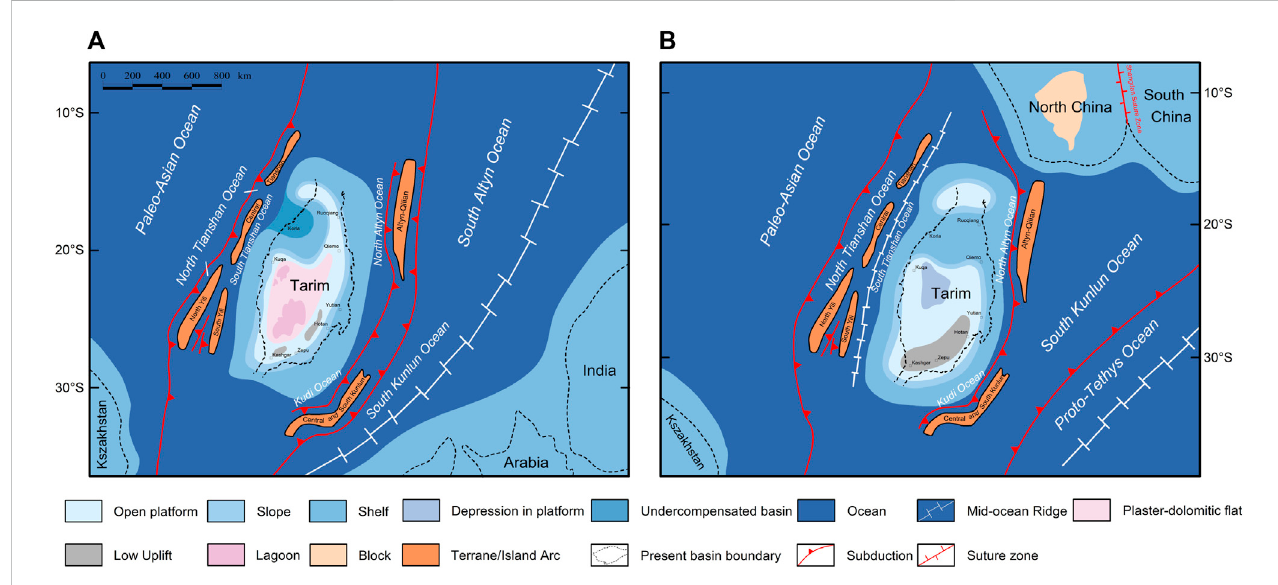
FIGURE 8 Tectono-paleogeography of Tarim and adjacent areas in late Middle Cambrian (A) and late Cambrian (B) .